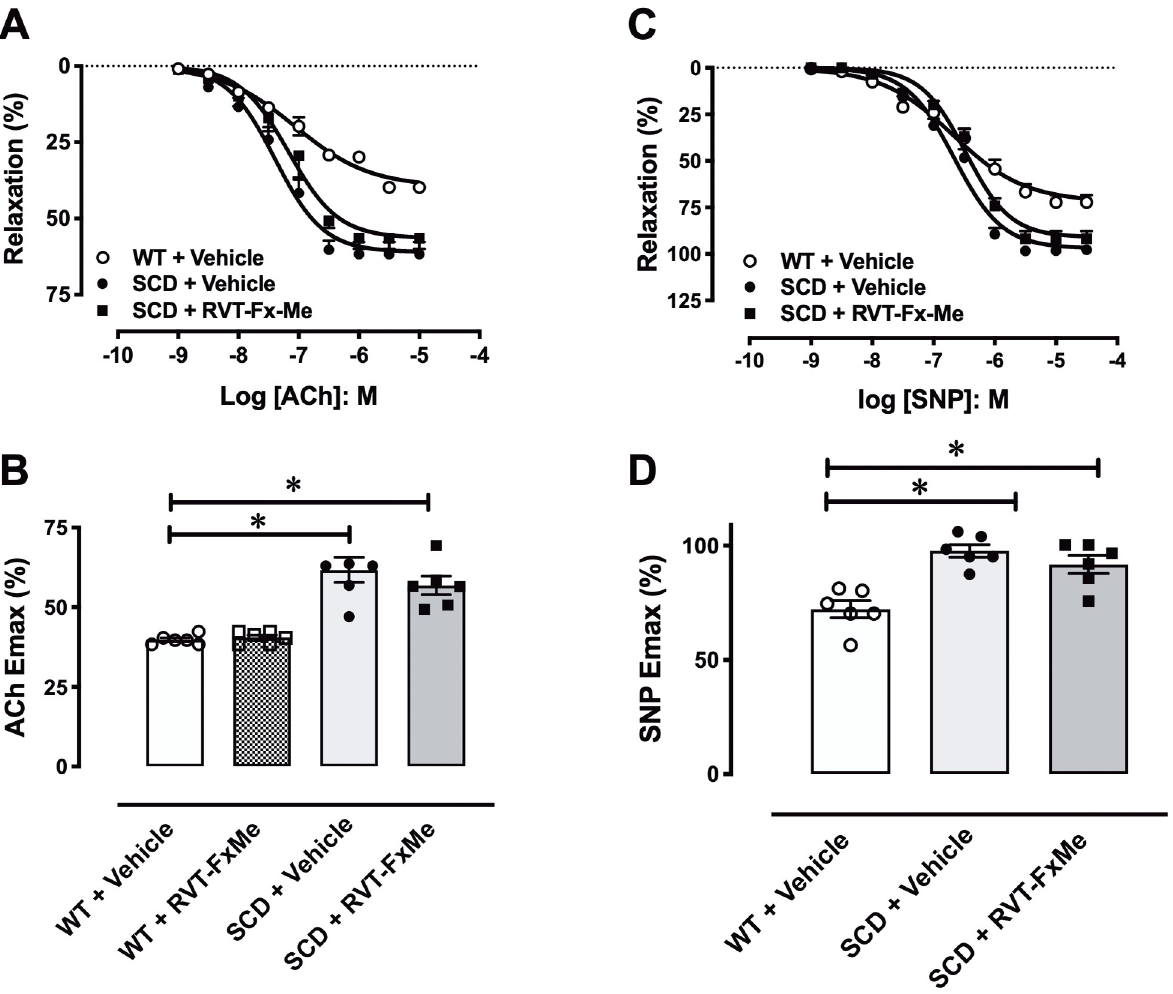
Fig 5. Concentration-response curves to acetylcholine (ACh) sodium nitroprusside (SNP) in corpus cavernosum strips from WT and SCD mice treated with RVT-FxMe (25 mg/kg/day, 2 weeks) or vehicle. Data were calculated relative to the maximal changes from the contraction produced by phenylephrine (10 − 5 M for WT mice and 3 × 10 − 6 M for SCD mice) in each tissue, which was taken as 100%. Data represent the mean ± SEM for 6 mice in each group. One-way ANOVA: � P < .05 vs WT + Vehicle.